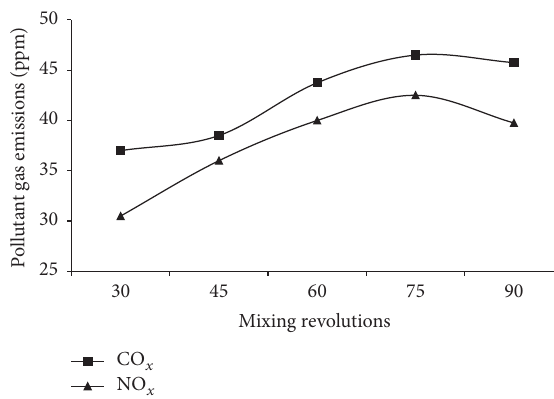
Figure 3: Effect of number of mixing revolutions on pollutant